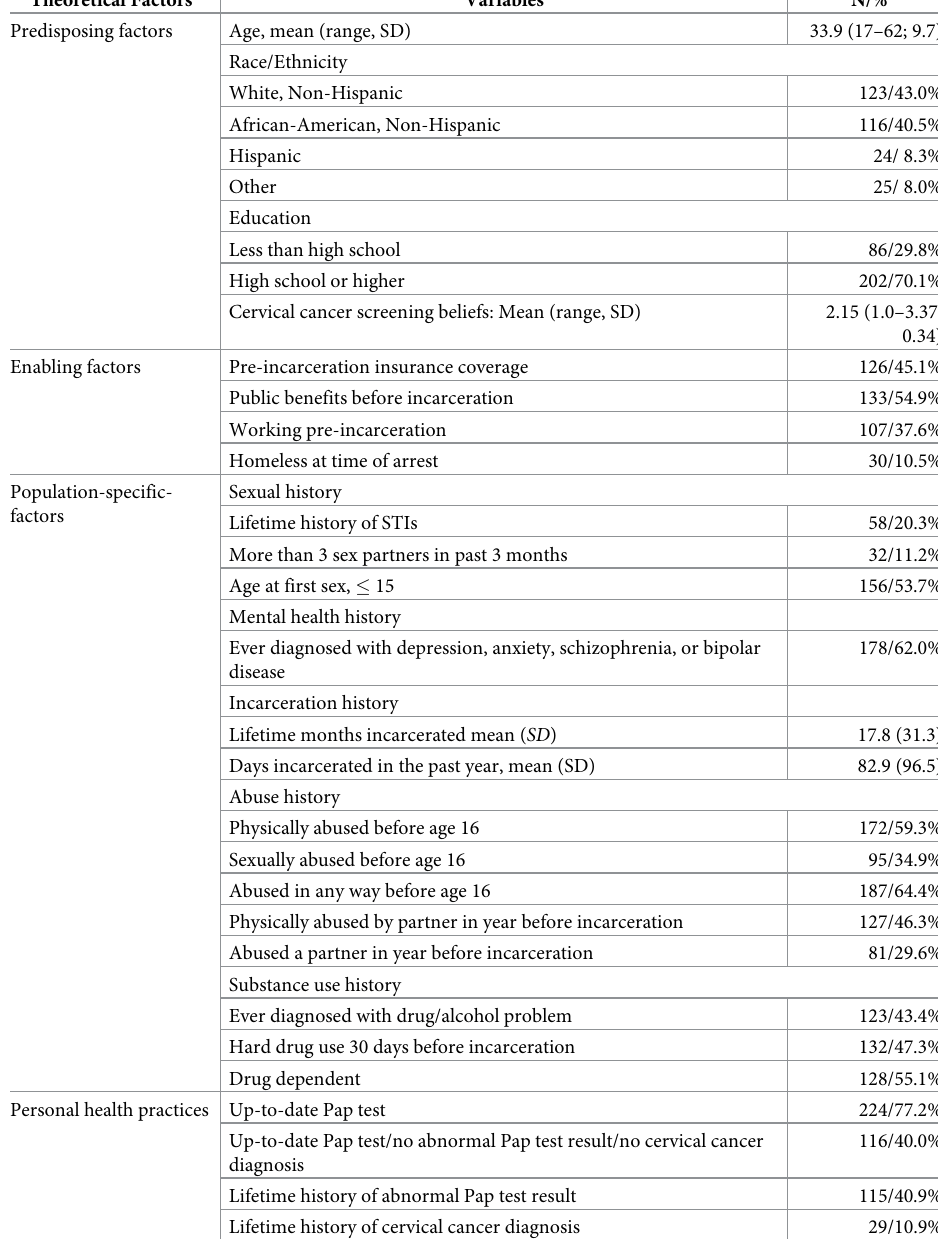
Table 1. Characteristics of sample, N =